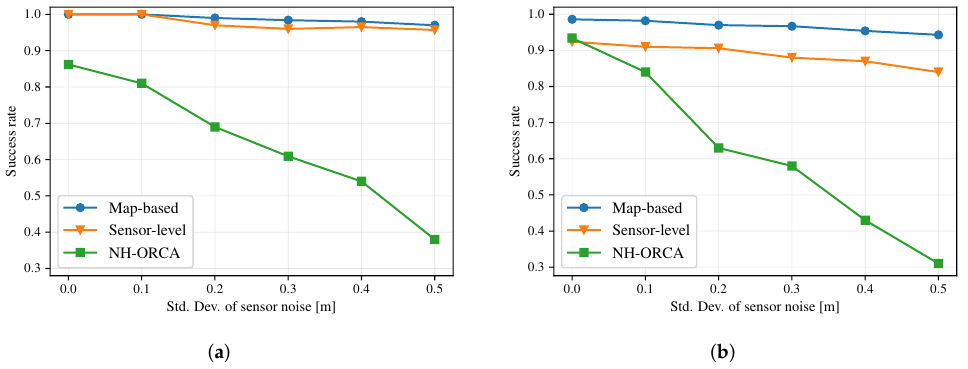
Figure 11. ( a ) Comparison of the success rate of NH-ORCA policy, Sensor-level policy and Map-based policy in the circle scenario with 12 robots, when the standard deviation of sensor noise increases. ( b ) Comparison of success rates between the Map-based policy, Sensor-level policy and NH-ORCA in the new random scenario with 10 robots, when the standard deviation of sensor noise increases.